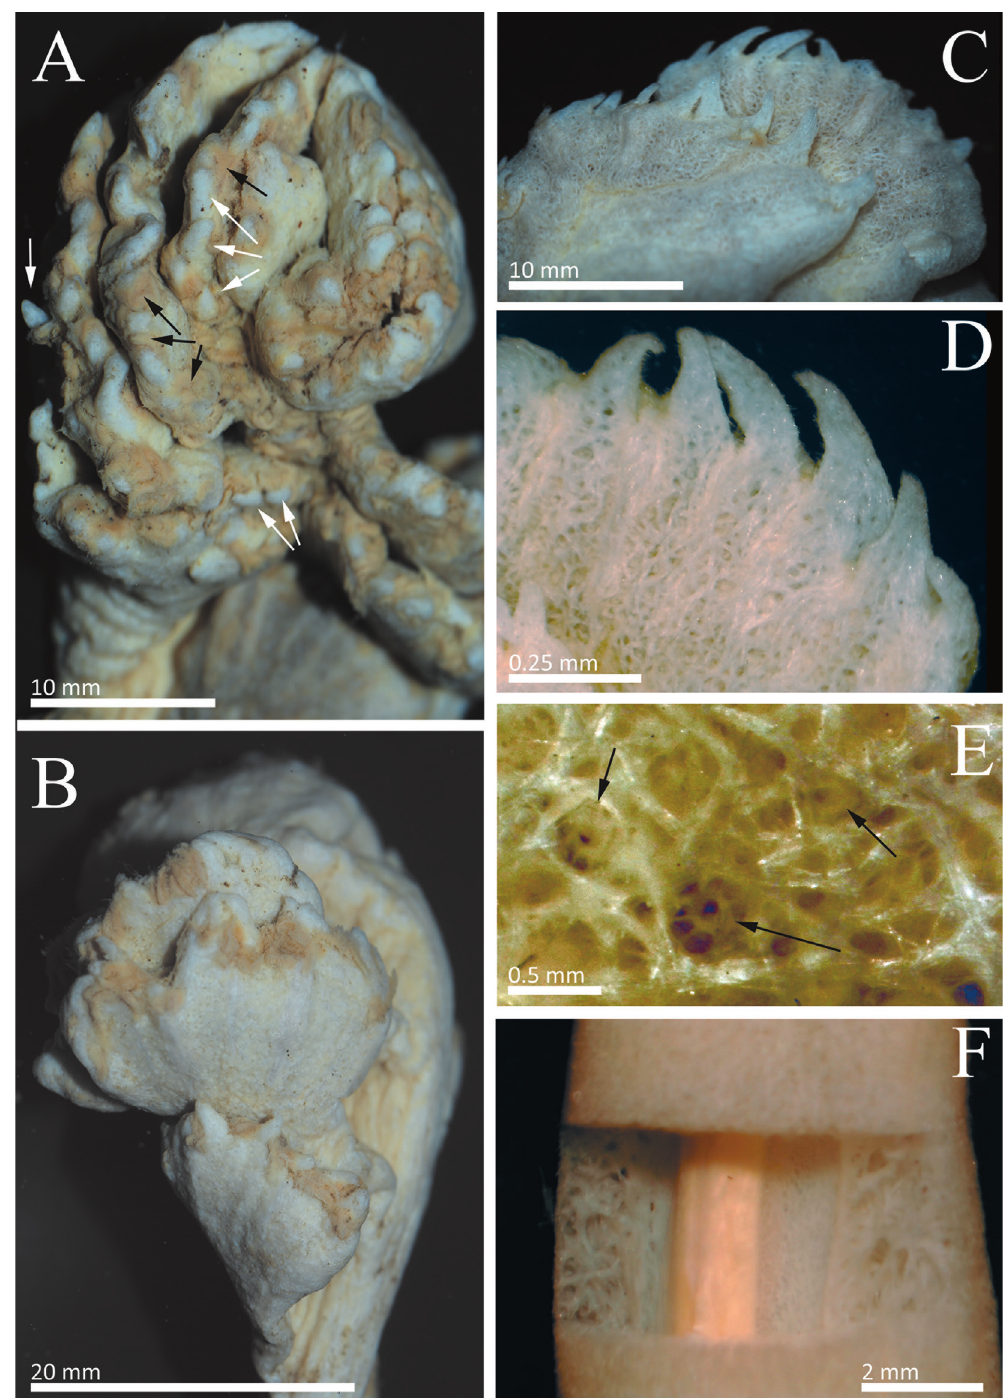
Fig. 6. Gyrophyllum hirondellei Studer, 1891. A–B . Detail of the colony MNHM OCT.A.579 in upper- ventral and lateral view, respectively, showing BPPs (white arrows) and partially retracted autozooids (black arrows). C–D . Detail of polyp leaves and ventral edge of a polyp leaf of the colony BECA (OPEN-660), note trabecular appearance of lateral surfaces and well developed BPPs. E . Detail of lateral surface of a polyp leaf, showing trabecular arrangement of sclerites and siphonozooid openings (arrowed). F . Partial section at rachis-peduncle limit, showing the thick trabecular wall and the axis with longitudinal